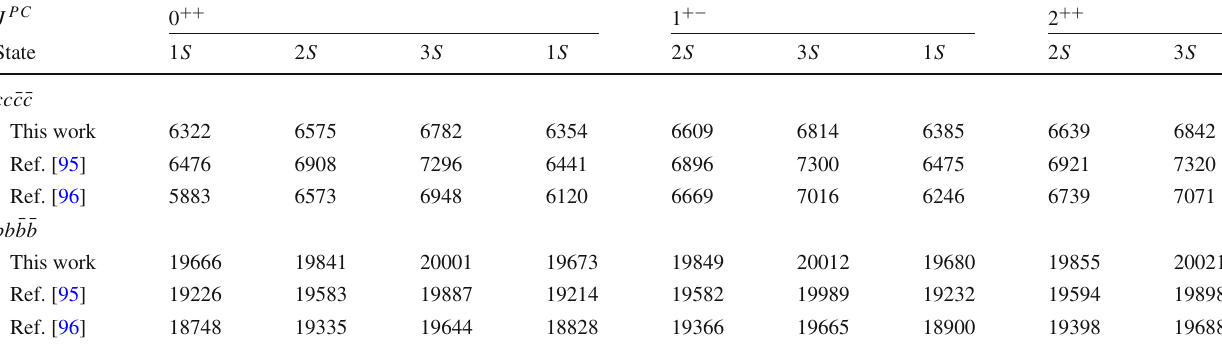
Table 8 Comparison of calculated fully-heavy tetraquark cc ¯ c ¯ c and cc ¯ c ¯ c bb ¯ b ¯ b masses for ground (1S) and radial excited states (2S, 3S) with quantum numbers J PC = 0 ++ , 1 +− and 2 ++ . All results are in MeV